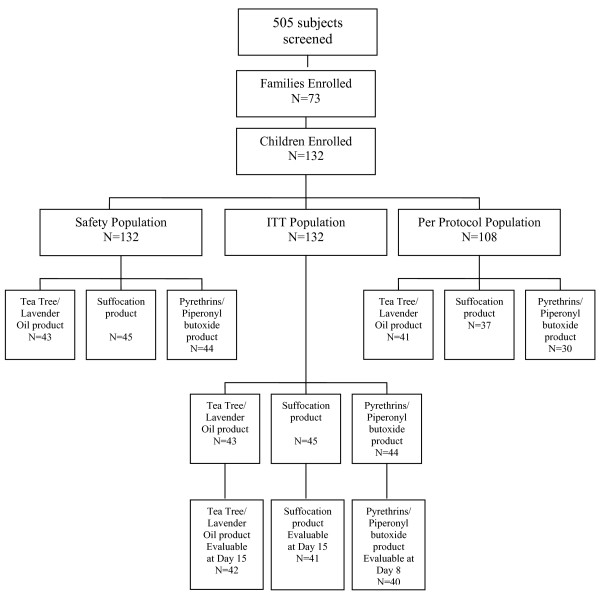
Disposition of subjects.